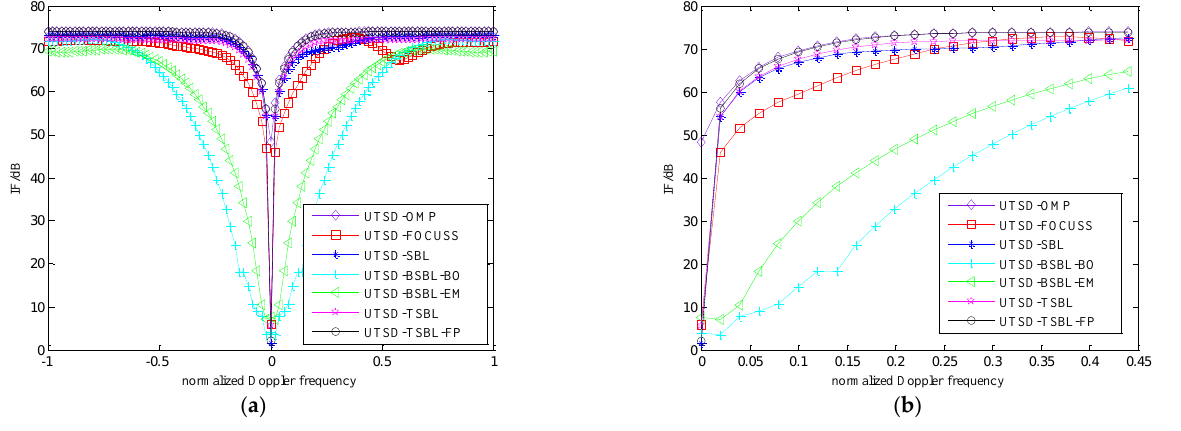
Figure 7. Improved factor comparison of different algorithms with UTSD: ( a ) improved factor performance; ( b ) local improved factor performance.